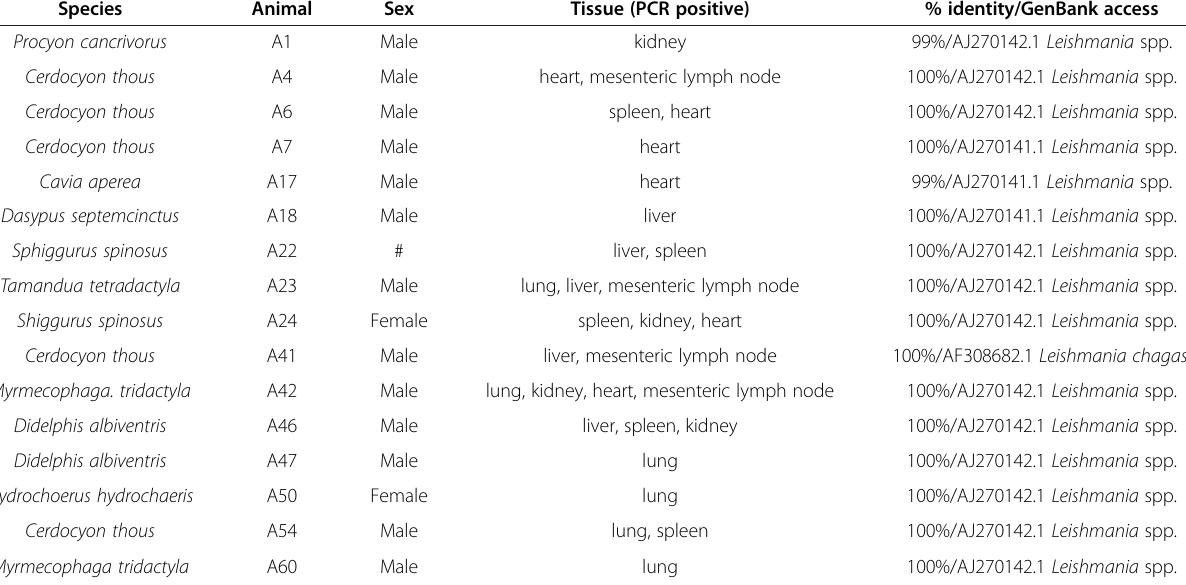
Table 1 Data on road-killed wild animals, including the sex, tissue, PCR and sequencing results for molecular detection on Leishmania spp. and Leishmania chagasi